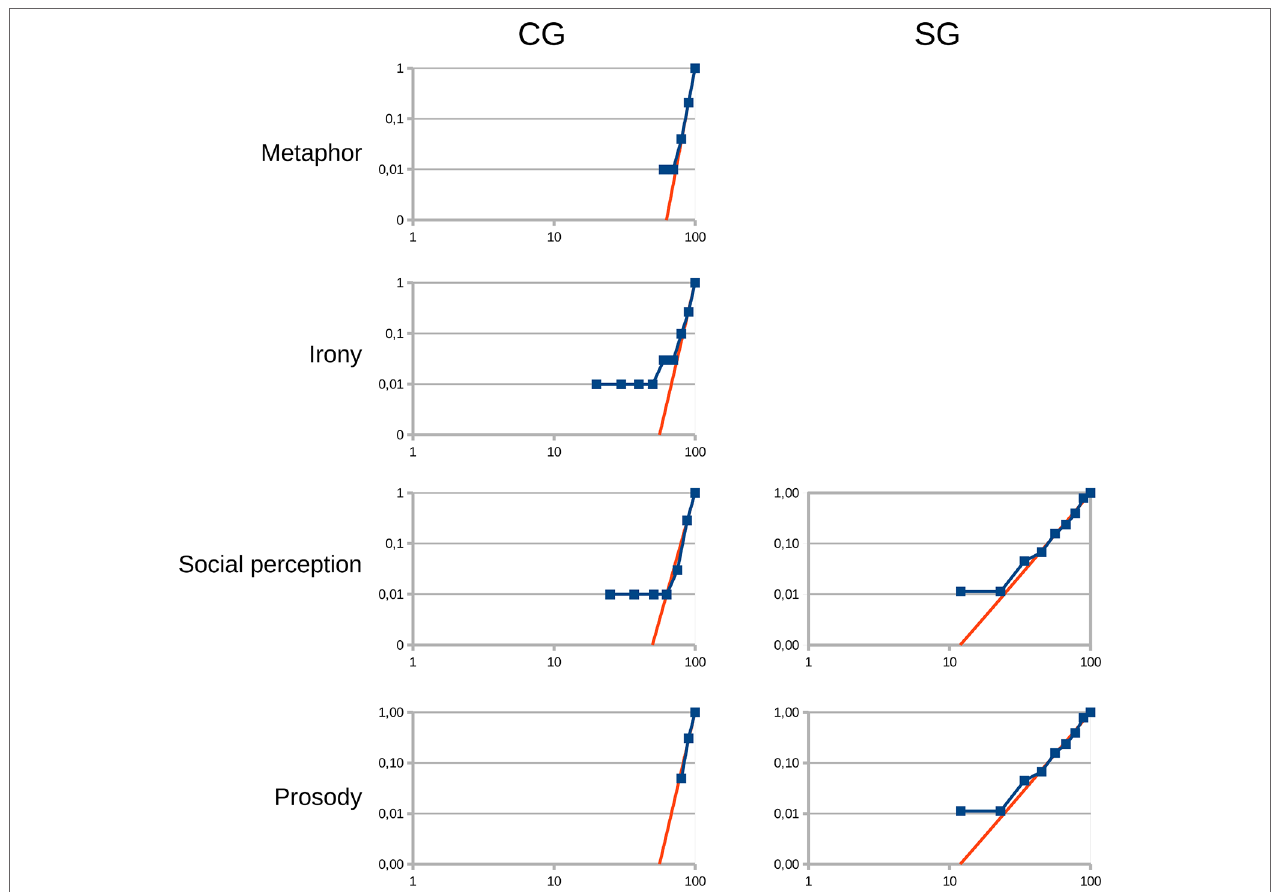
FIgURe 6 | Power-law distributions in the irony, metaphor, emotional prosody and social perception conditions in the control group (CG) and in the patients diagnosed with schizophrenia group (SG). X-axis: Response rates in %; Y-axis: Cumulative ratios of those who achieved the given response rates (ratio from 0 to 1).